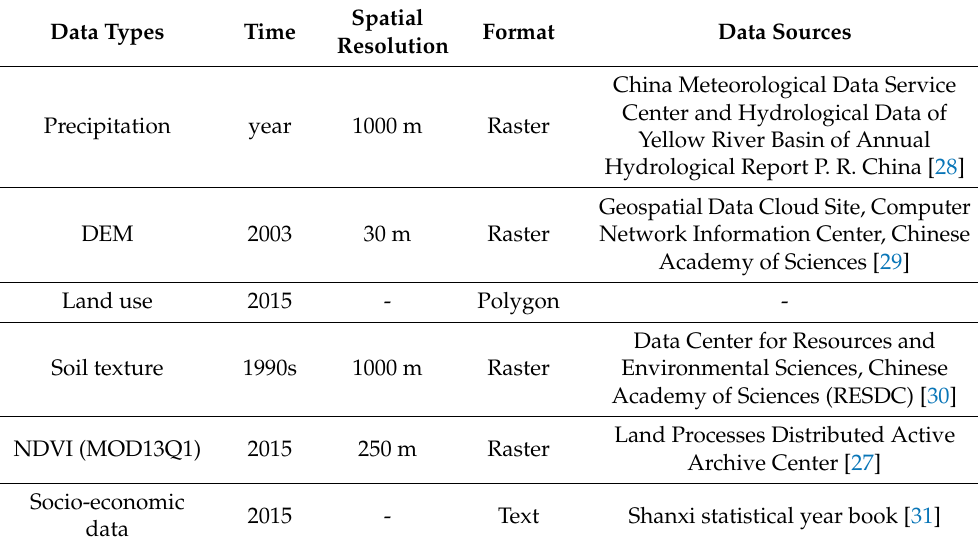
Table 1. Data sources and